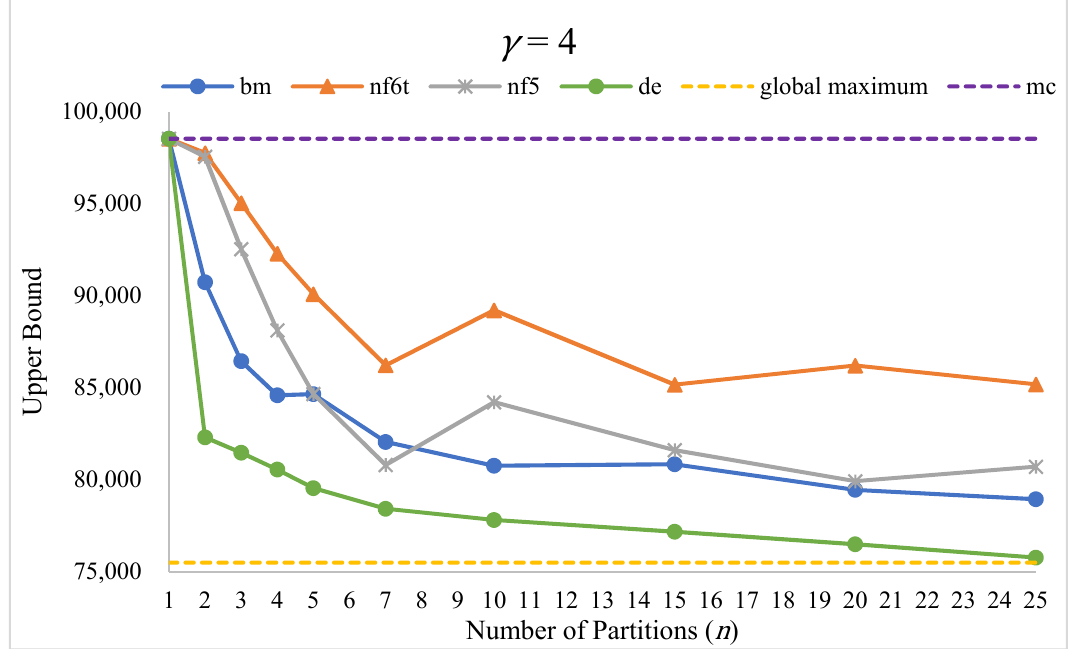
Figure 10. Convergence-indicating curves of the bm , de , nf5 , and nf6t relaxation schemes for γ = 4. The difference in magnitude between an upper bound and a global optimum can denote the tightness of a relaxation scheme: A smaller difference indicates greater tightness and vice versa. A convexified model using nf5 employed more constraints and an extra continuous variable that resulted in a tighter relaxation than nf6t , but at the expense of a larger size, which is consistent with the results reported by Gounaris et al. [39], while that of bm and de varied with respect to γ . In terms of the relaxed model sizes, which